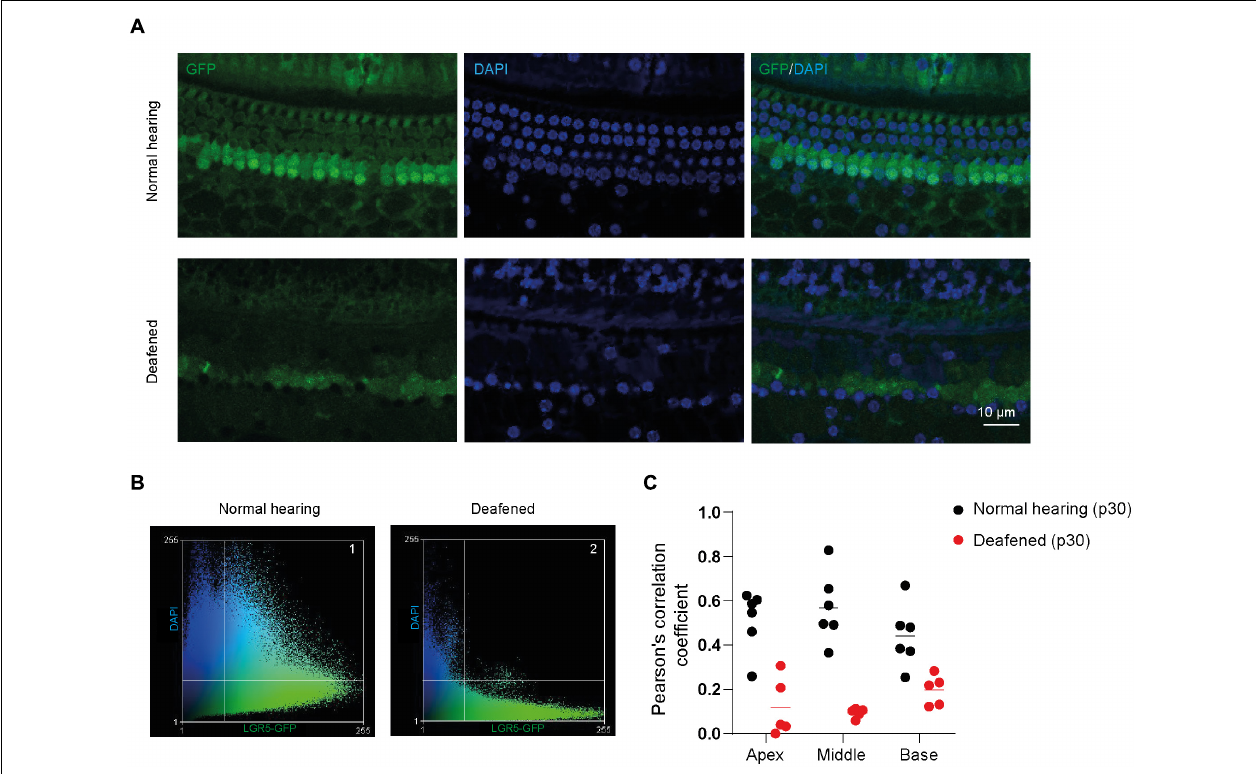
FIGURE 4 | GFP expression is located in different subcellular compartments in the cochlea of normal-hearing and deafened mice. (A) Representative images of immunofluorescence microscopy of whole-mount dissections of the cochlea of normal-hearing and deafened Lgr5 GFP mice stained with GFP in green, DAPI in blue and merged images. (B) Scatter plot of green intensity vs. blue intensity of images in panel (A). Square 1 represents the pixels that are expressed in both channels in normal hearing and square 2 represents the pixels that are expressed in both channels in deafened. (C) Pearson’s correlation coefficient (PCC) calculated for the apex, middle and base of the cochlea of normal-hearing and deafened Lgr5 GFP mice. Bar = 10 µ m. n normal hearing ( p30 ) = 6; n deafened ( p30 ) =